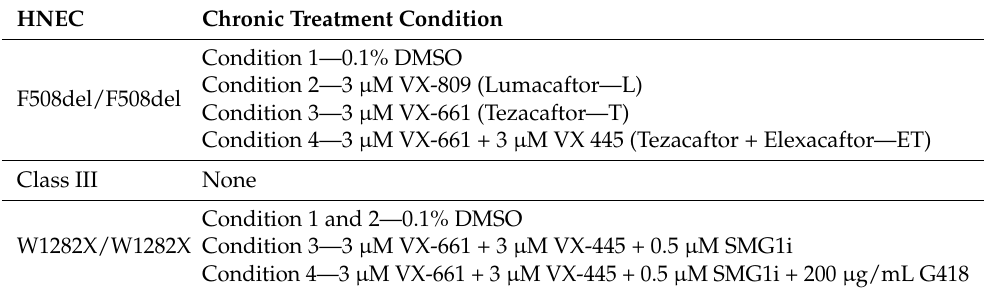
Table 1. Chronic drug treatment conditions of